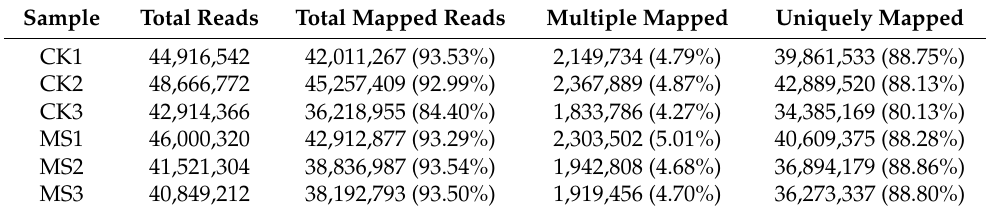
Table 1. Statistical results of reads and reference pineapple genome alignment in normal fruit (CK) and mildly watercored fruit